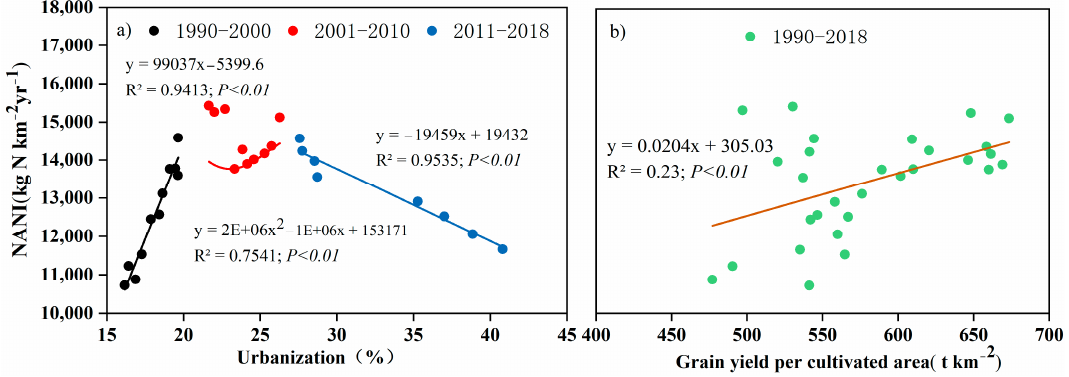
Figure 5. The relationship between the NANI and urbanization ( a ) and grain yield ( b ) during the period 1990–2010 in Chaohu Lake Basin.